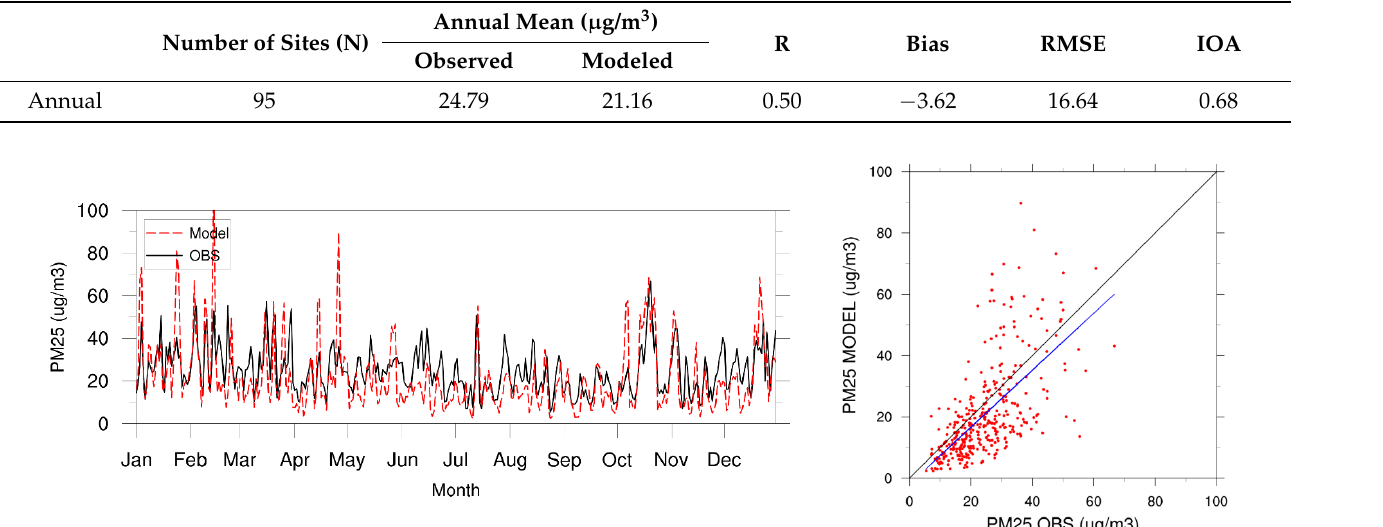
Figure 3. Comparison of observed and simulated concentrations of PM 2.5 over the South Korea AQMS in 2015. Table 2. Statistics for PM 2.5 at the South Korea air quality monitoring stations.